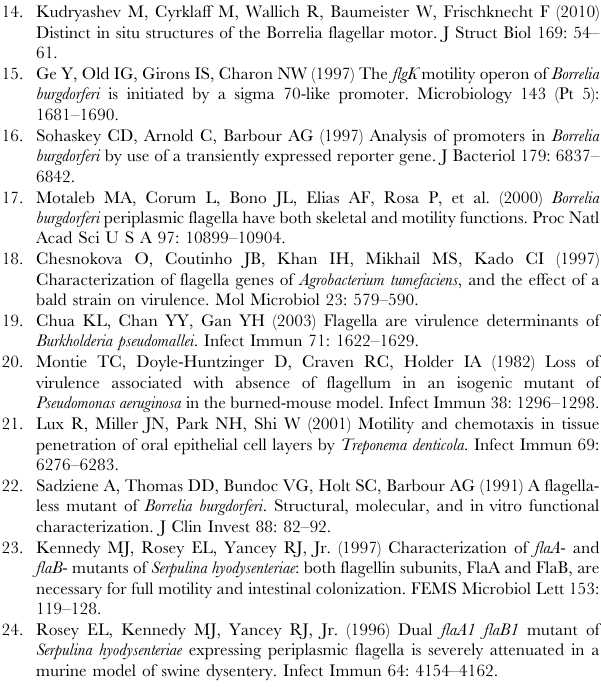
Figure S1 Alignments of (A) the fliH genes and (B) the predicted amino acid sequences of FliH from WT B. hermsii and the isogenic fliH mutant. Table S1 Oligonucleotides used for PCR, sequencing and Realtime